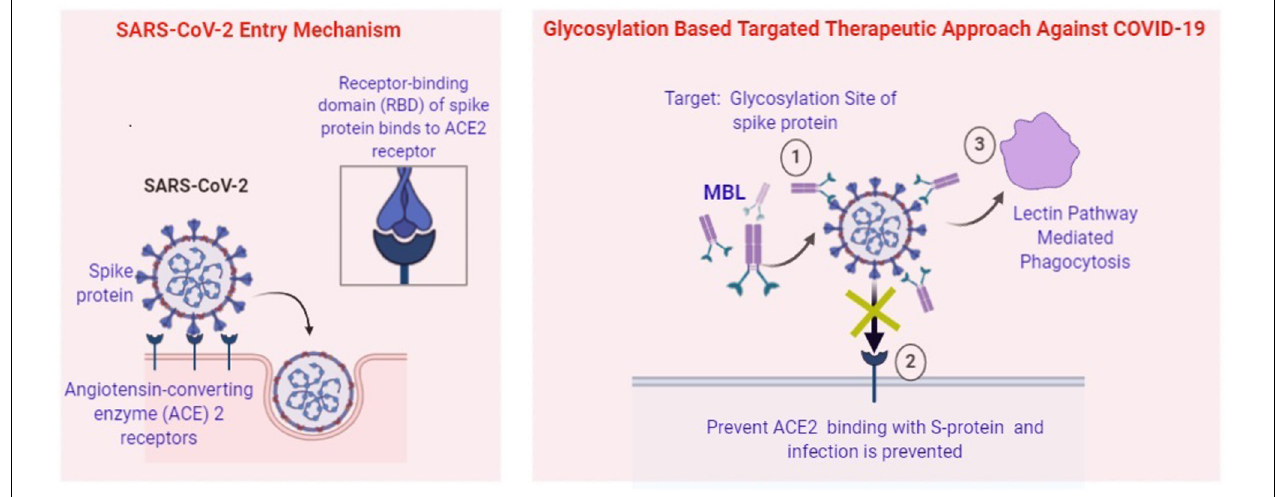
FIGURE 2 | Potential Role of MBL in prevention of SARS-CoV-2. (1) Attachment of MBL at the glycosylation site of Spike Protein by “Lock and Key” mode. (2) Prevent ACE2 mediated entry of viral pathogen. (3) Lectin pathway-mediated phagocytosis of intracellular pathogens.